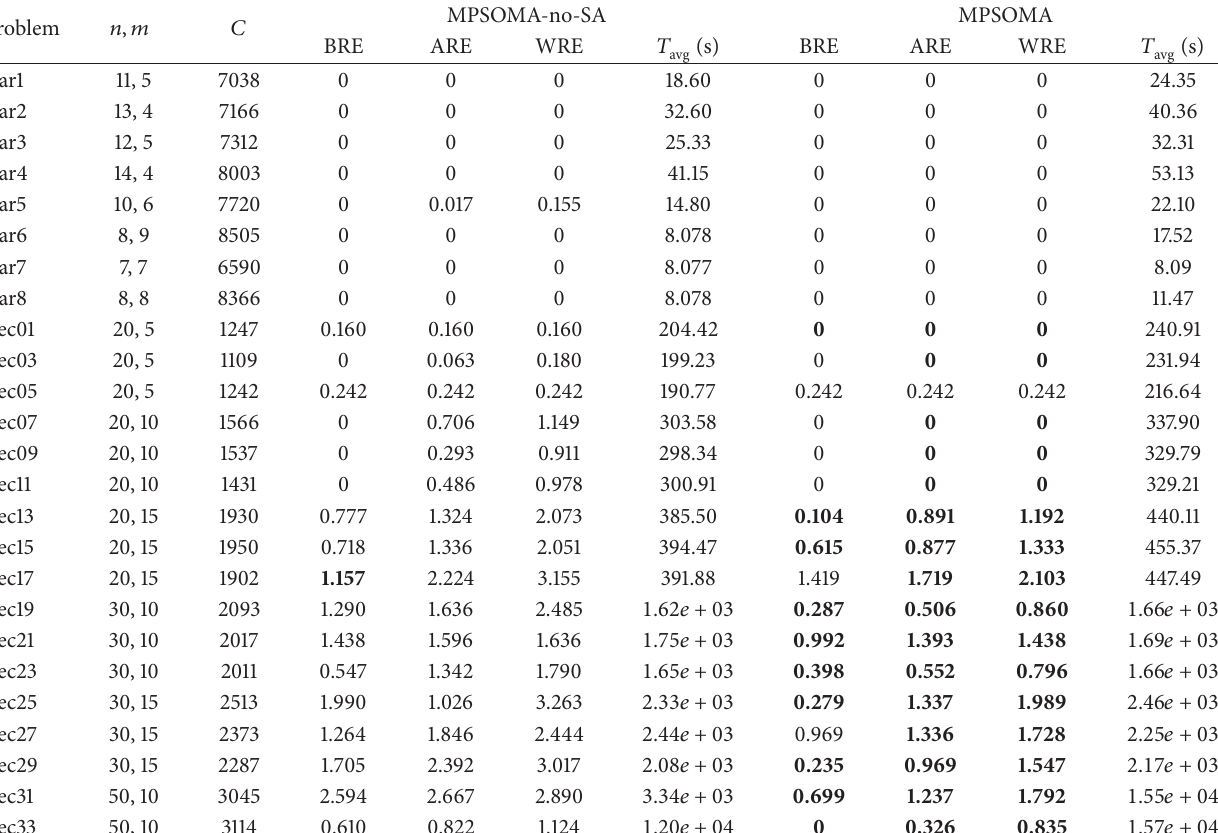
Table 5: Comparisons of MPSOMA-no-SA and